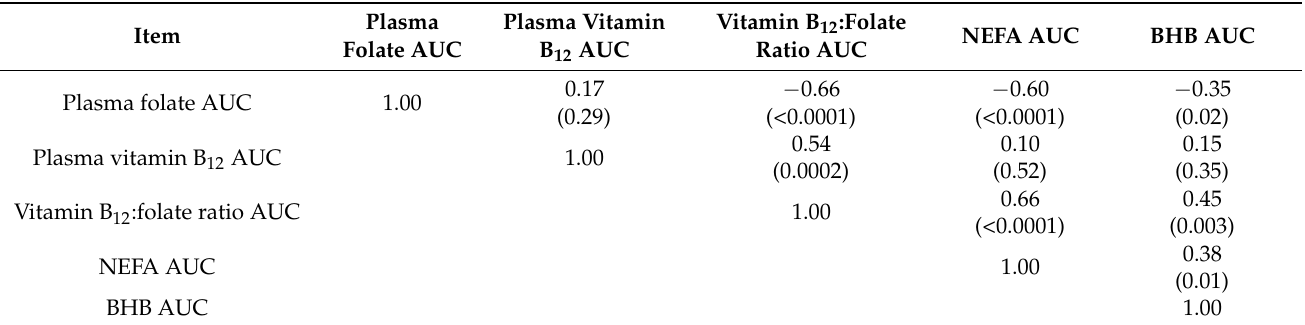
Table 6. Spearman rank correlation coefficients ( p -values in parentheses) between peripartum plasma folate, vitamin B 12 , NEFA, and BHB concentration AUCs 1